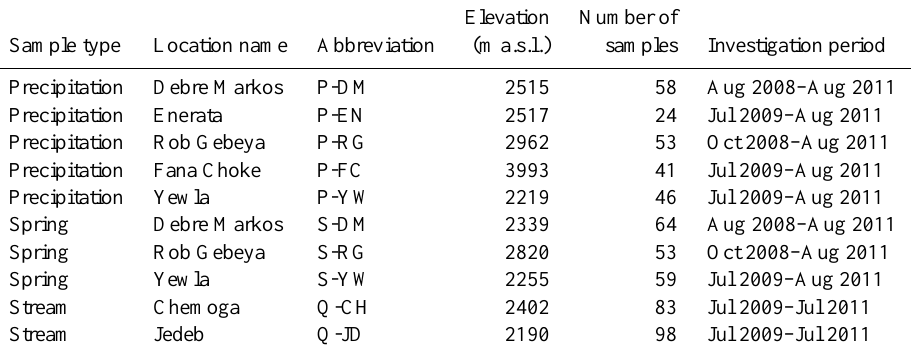
Table 2. Description of isotope sample locations and total number of samples taken during the investigation period (August 2008– August